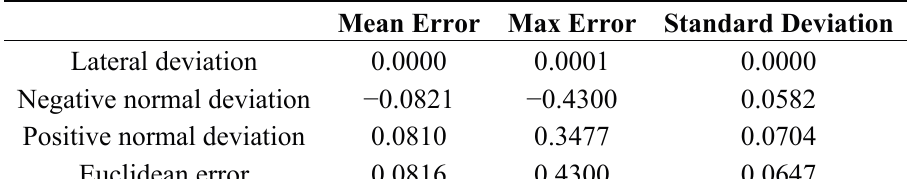
Table 2. The error evaluation of the surface.